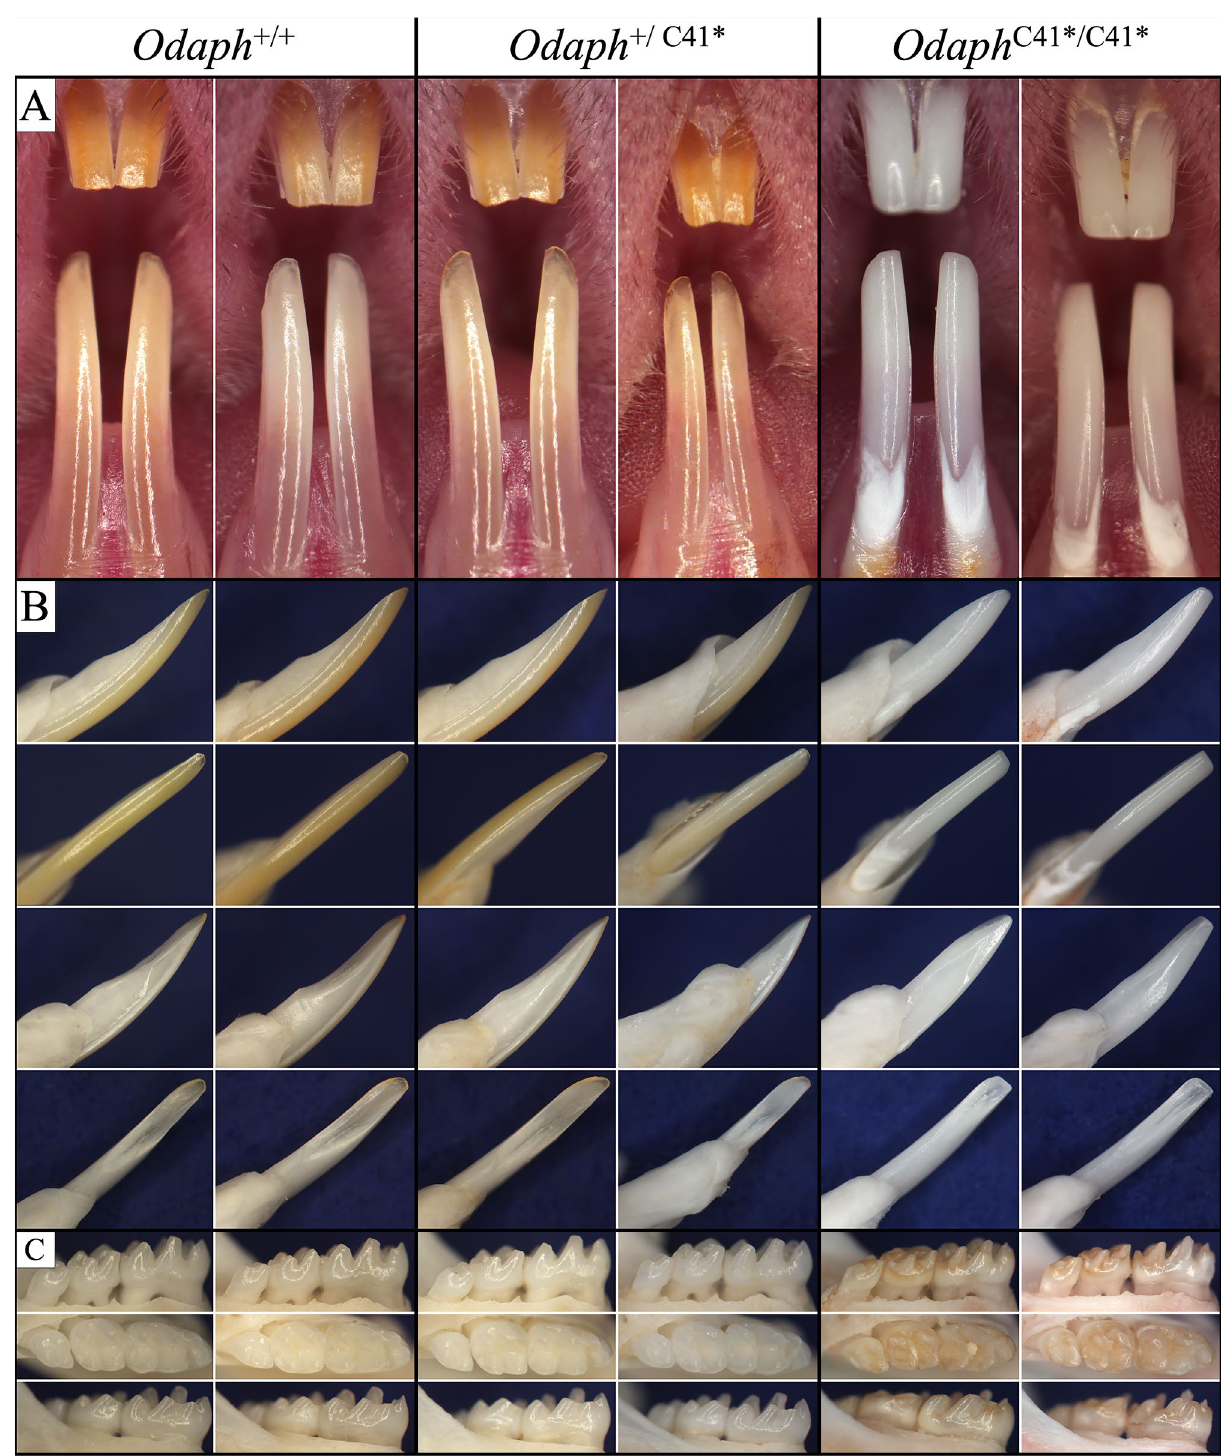
Figure 1. Appearance of Odaph +/+ , Odaph +/C41* , and Odaph C41*/C41* Incisors and Molars at 7-weeks. There were no appreciable differences in dental phenotype observed between Odaph +/+ and Odaph +/C41* mice. Tooth size and morphology were similar in the three genotypes. ( A ) Frontal view of maxillary and mandibular incisors. The Odaph C41*/C41* incisors appeared to be severely hypomineralized. Their incisors were chalky white and the enamel had abraded from dentin surface down to the cervical region. ( B ) Mesial, labial, distal, and lingual (lower right) views of the mandibular incisors. The Odaph C41*/C41* incisal edge is flat and appears to be shorter than the wild-type due to attrition. ( C ) Buccal, Occlusal, and Lingual views of mandibular molars. No differences in alveolar bone level were observed among the three genotypes. The Odaph C41*/C41* molars were discolored and had undergone significant